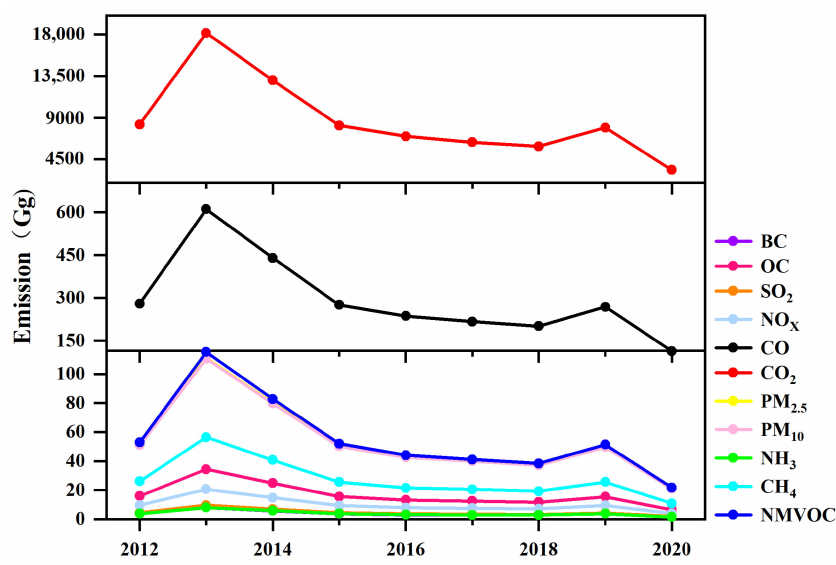
Figure 3. Yearly emissions emitted from crop residue open burning from 2012 to 2020.